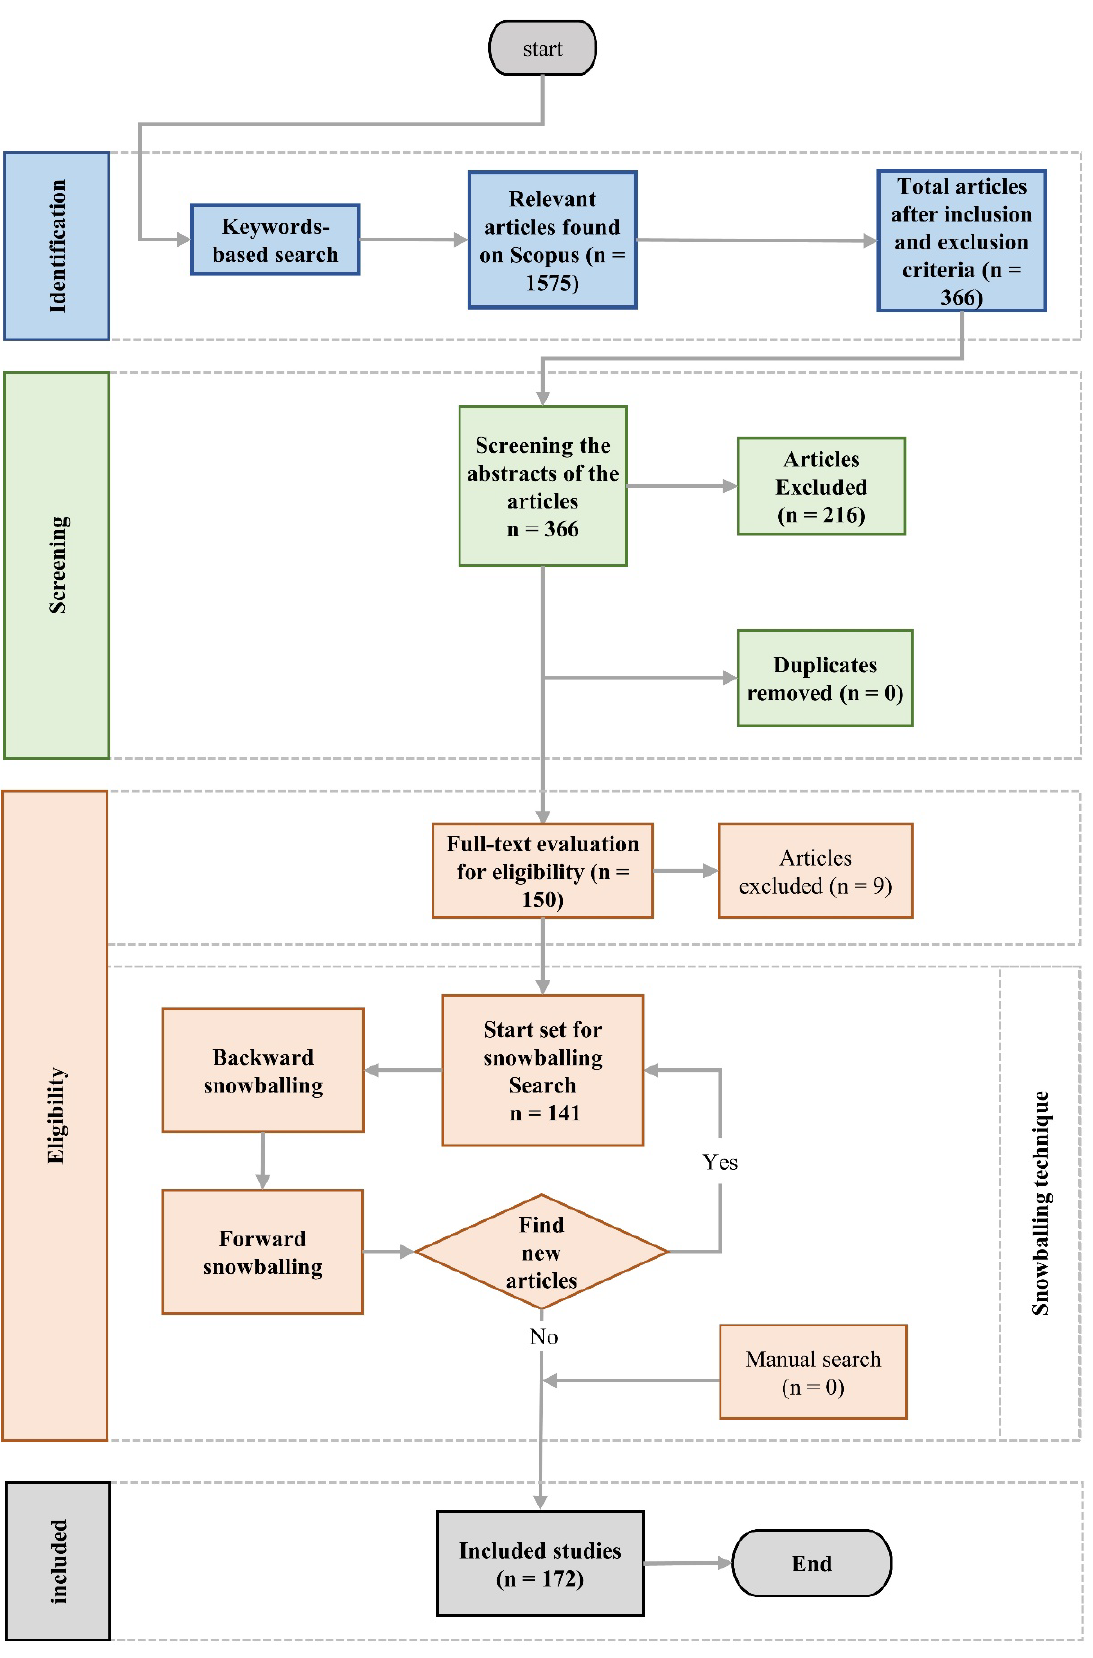
Figure 2 . PRISMA technique of screening and selecting publications. Figure 2. PRISMA technique of screening and selecting